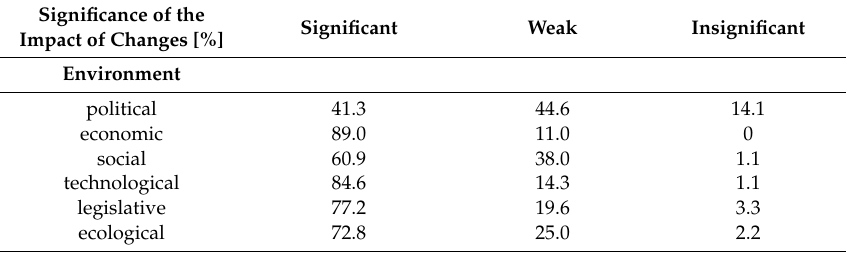
Table 5. Evaluation of the significance of impacts from the external environment. Significance of the Impact of Changes [%]